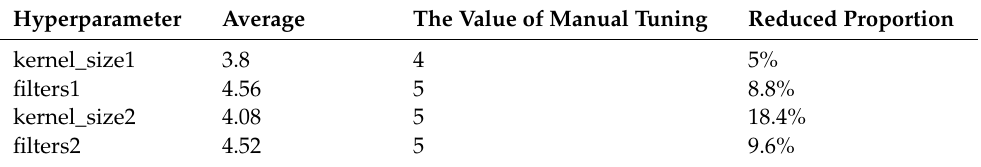
Table 6. Optimal structural parameter distribution of 50 independent operations in GA–PSO–CNN